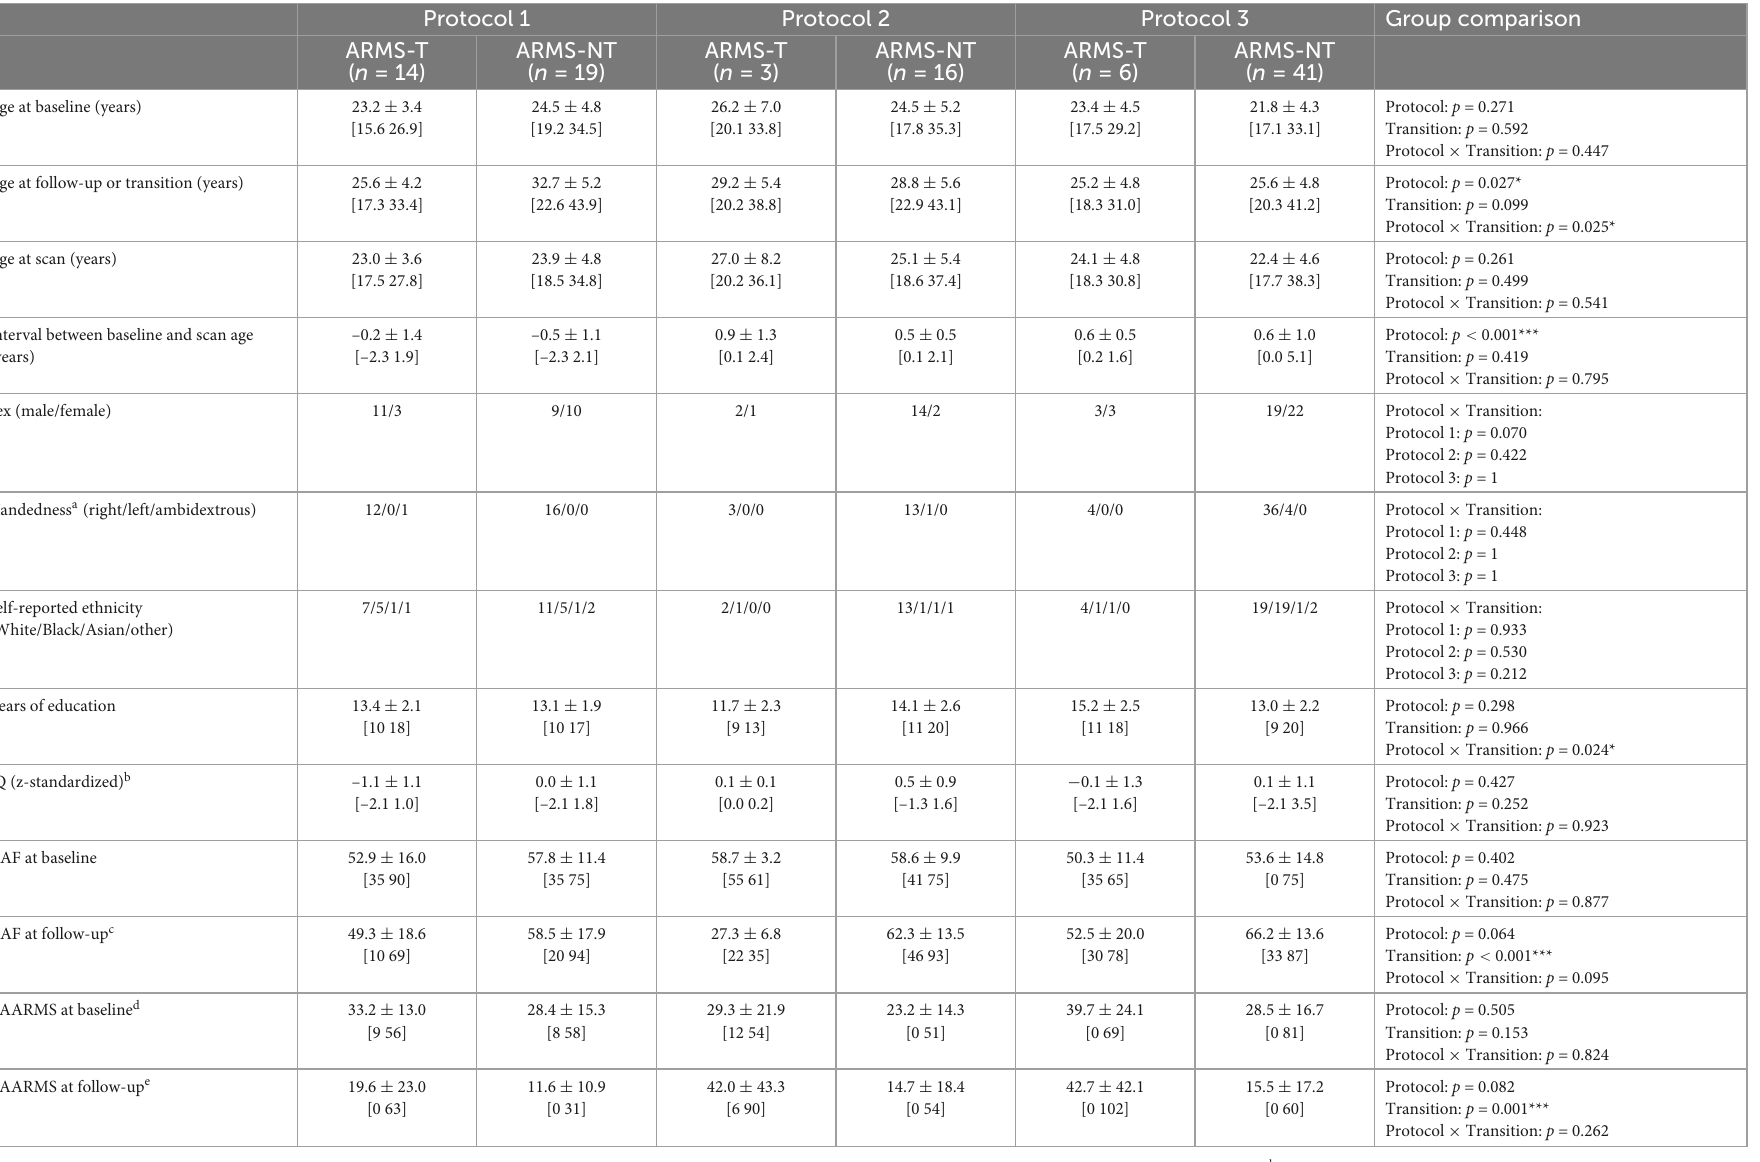
TABLE 1 Socio-demographic and clinical information of the At Risk Mental State (ARMS) sample with structural MRI data.